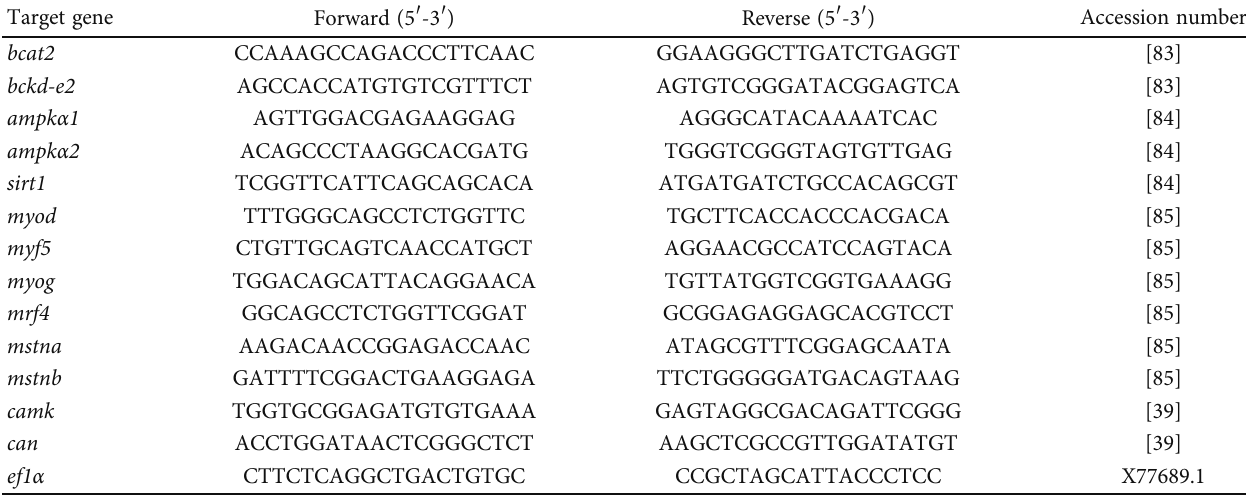
Table 2: Nucleotide sequences of primers used to quantify gene expressions by real-time PCR. Target gene